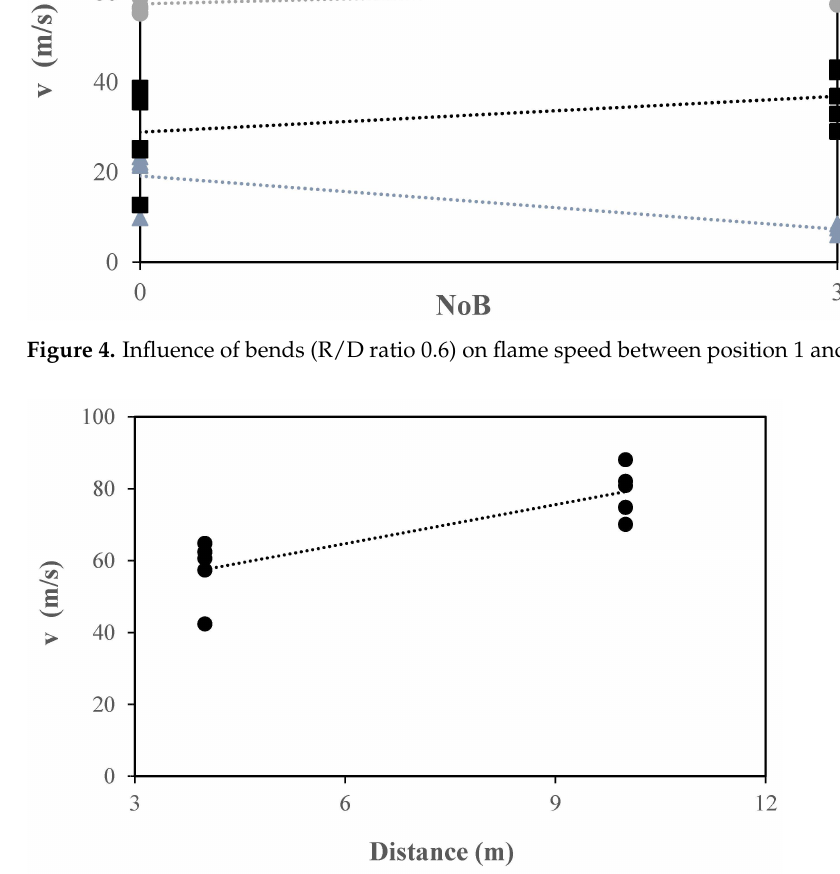
Figure 5. Trend in flame speed along the duct for Al dust using bends (R/D ratio 0.6) calculated from position 1 to 2 and from 2 to